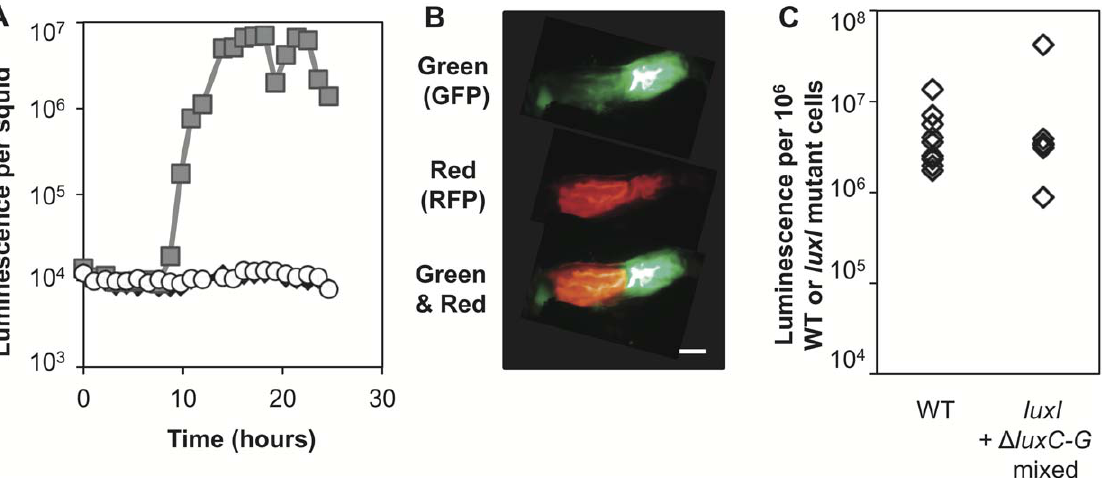
Figure 5. Inter-strain bioluminescence induction in the host light organ. (A) Relative luminescence induction over time for apo-symbiotic squid (black triangles) and squid infected with either the wild type (gray squares) or the VCW2G7 luxI mutant (empty circles). (B) GFP-labeled D luxCDABEG (EVS102) cells were mixed with RFP-labeled luxI mutant (VCW2G7) cells at a ratio of , 1:1 to inoculate apo-symbiotic juvenile squid. At 24 hr post infection, squid were dissected and imaged by epifluorescence microscopy to determine the spatial location of both cell types within the squid light organ using filters that allowed visualization of green fluorescence (top), red fluorescence (middle), or green and red fluorescence (bottom). Scale bar indicates approximately 100 m m. (C) Squid were then homogenized and plated to determine the CFU per squid for each cell type and to calculate the luminescence per 10 6 wild-type or luxI mutant cells. Data include nine squid colonized with wild type and six co-colonized squid. Co-colonized squid contained 12–92% of the luxI mutant in the colonization. For reference, squid clonally colonized with the luxI mutant have an average background relative luminescence per 10 6 CFU of , 10 4 on this scale.